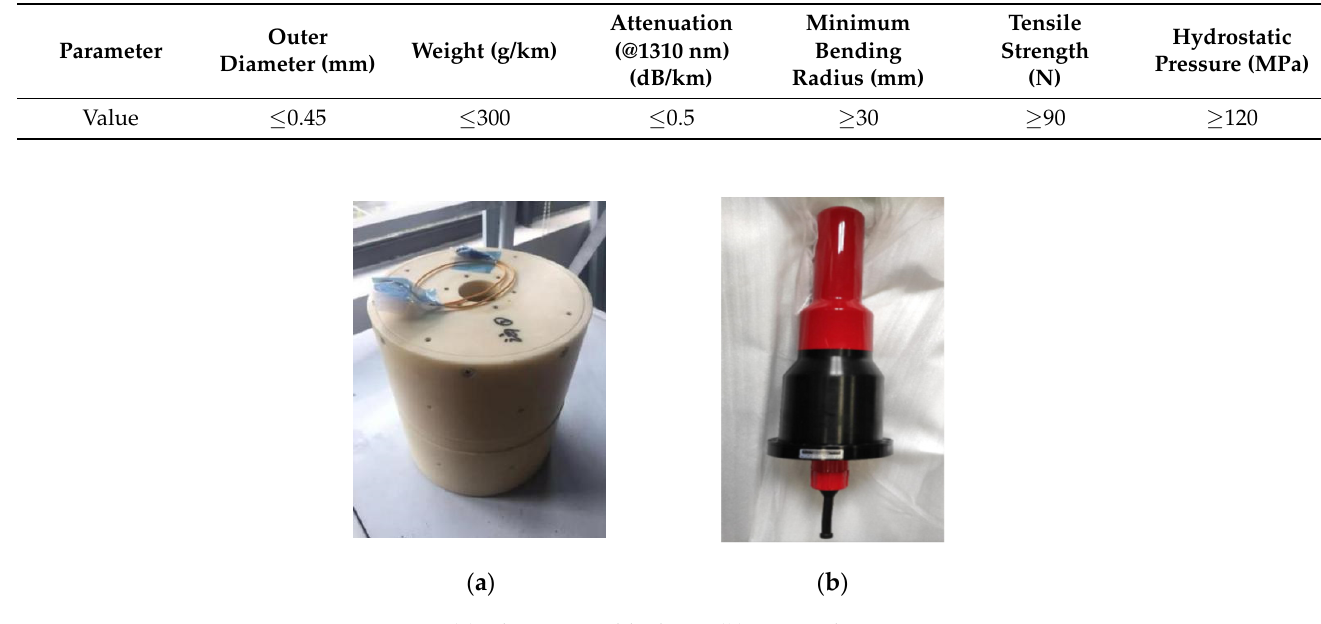
Figure 11. ( a ) Pressure contour in the forward direction ( v = 1.5 kn); ( b ) pressure contour in the descending direction ( v = 0.5 kn). Table 6. Thruster specification.